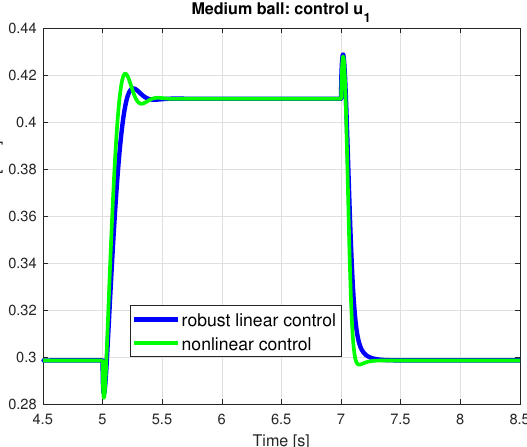
Figure 18. Medium ball—control variable u : comparison of simulation results for nonlinear and robust linear pole-placement